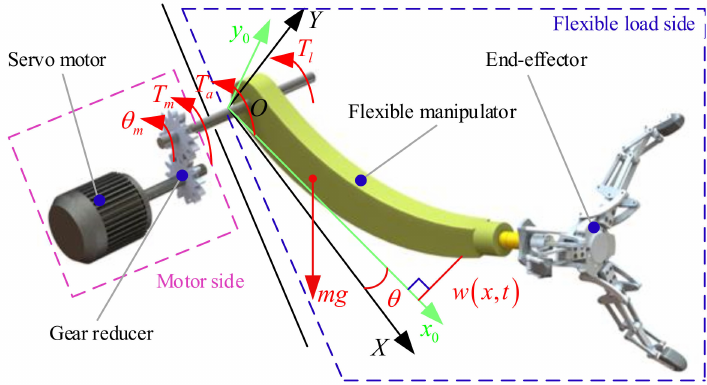
Figure 1. Schematic diagram of the servo system for flexible